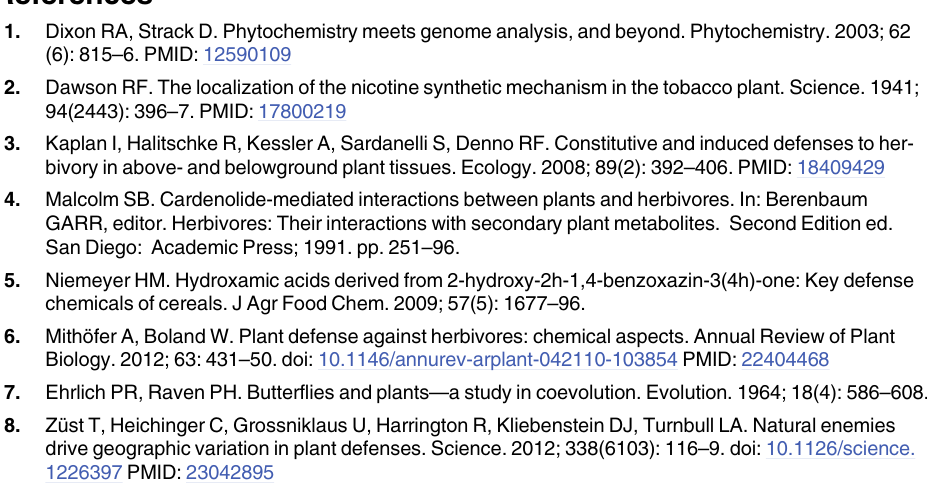
S7 Table. Density of M . melolontha per m 2 in common garden field experiment at the end of the flowering season in the second year. Initial density of M . melolontha in the herbivory treatment was 23 M . melolontha larvae per m 2